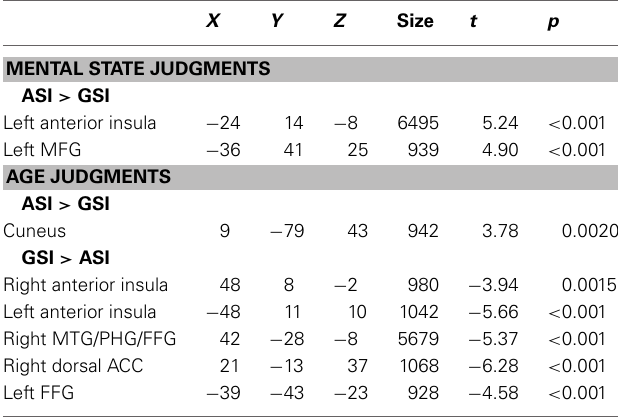
Regions identified in a whole-brain voxel-wise paired t-test to show differential functional connectivity to left posterior STS post-ASI vs. post-GSI for each judg- ment type (mental state and age). Abbreviations: MFG, middle frontal gyrus; MTG, middle temporal gyrus; PHG, parahippocampal gyrus; FFG, fusiform gyrus; ACC, anterior cingulate